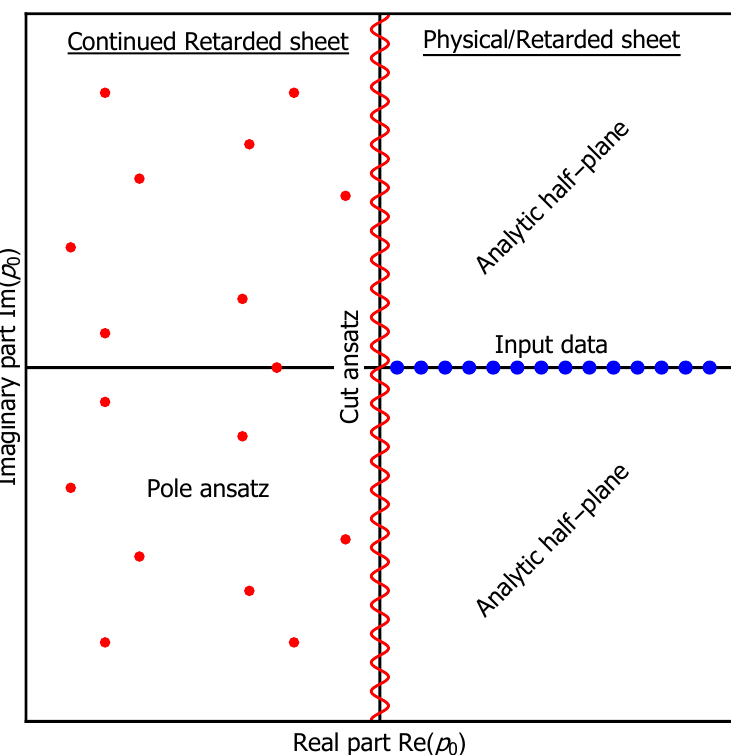
Figure 5: Schematic analytic structure of a retarded propagator. All non-analytic < 0 half-plane, reflecting the analyticity constraints from structures are in the Re p 0 the existence of a spectral